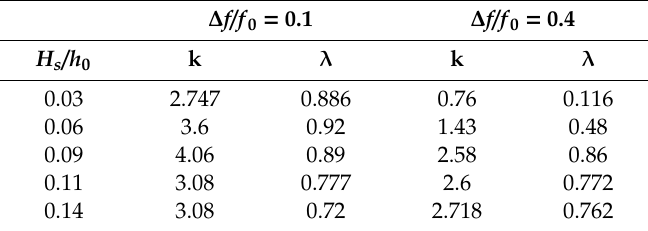
Table 2. Parameters of conditional Weibull distribution fitted to the corresponding datasets in Figure 7.